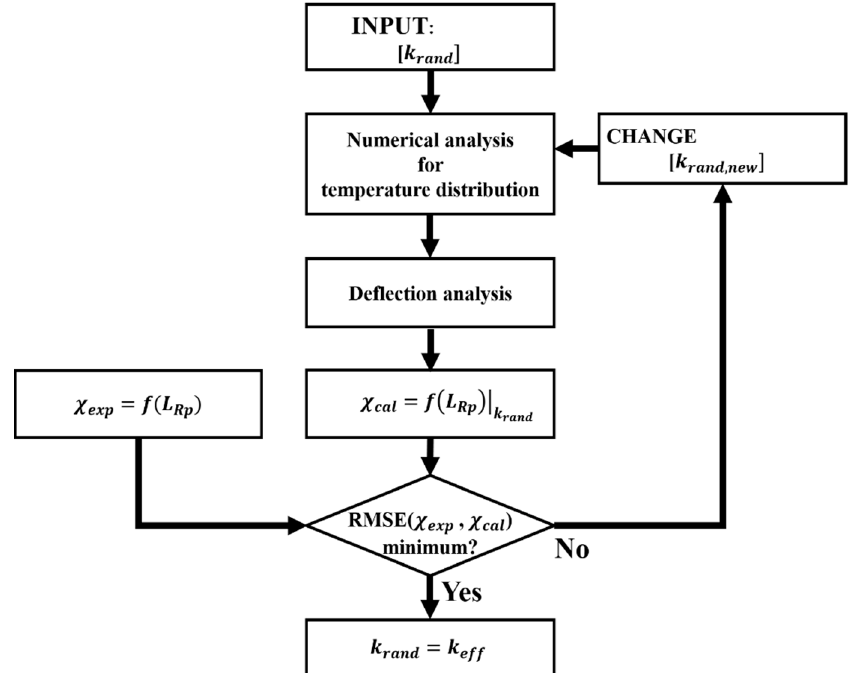
Figure 5. Algorithm for determination of thermal conductivity.